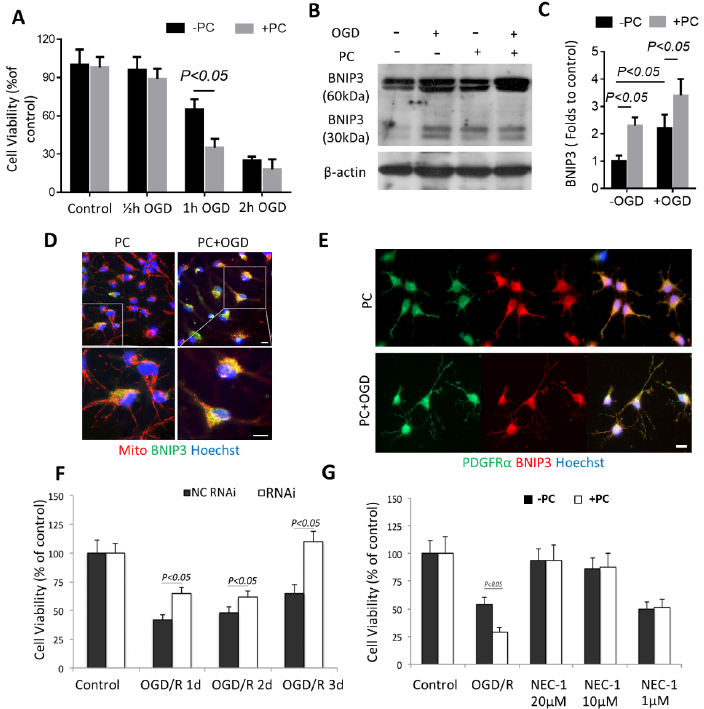
Figure 5. Preconditioning aggravates death of OPCs. The cultured cells were treated with or without preconditioning, and 24 h later, re-exposed to OGD. ( A ) Viability was determined by WST-1 assay. ( B ) Representative Western blots showing expression of BNIP3. ( C ) Densitometric quantification showed the ratio of BNIP3 to β -actin, normalizing the ratio of control as one. ( D ) Immunofluores- cence microscopic analyses showed that both preconditioning only and preconditioning + OGD cells had overlapping BNIP3 staining (green) and mitochondria staining (red). Bar, 10 μ m. ( E ) Immuno- fluorescence microscopic analyses showed that both preconditioning only and preconditioning + OGD cells had overexpressing BNIP3 (Red). The Red fluorescence from preconditioning only was weaker and more diffusive compared to preconditioning + OGD cells. Bar, 10 μ m. ( F ) Effect of BNIP3 knockdown on OPCs survival. OPCs were infected with BNIP3-shRNA (RNAi) or control scrambled shRNA (NC-RNAi), treated with OGD, and then allowed to recover. Cell viability assays were performed at different time points of reoxygenation. ( G ) Effect of BNIP3 inhibition on OPCs survival, after the lethal OGD, or preconditioned OPCs, either remained untreated or treated with Nec-1 (20, 10, or 1 μ M). Viability was determined by WST-1 assay. Results shown represent mean ± SD from 3 independent experiments.